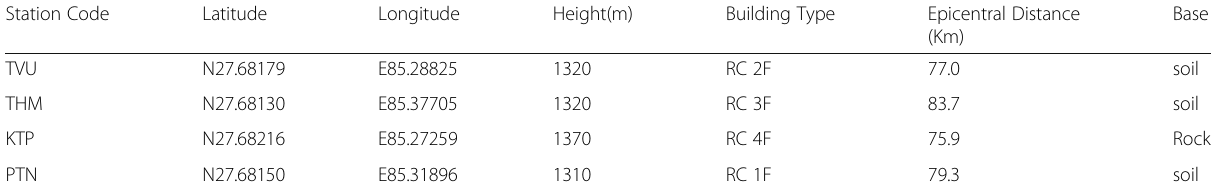
Table 1 Station code and their location information. Station Code Latitude Longitude Height (m) Building Type Station